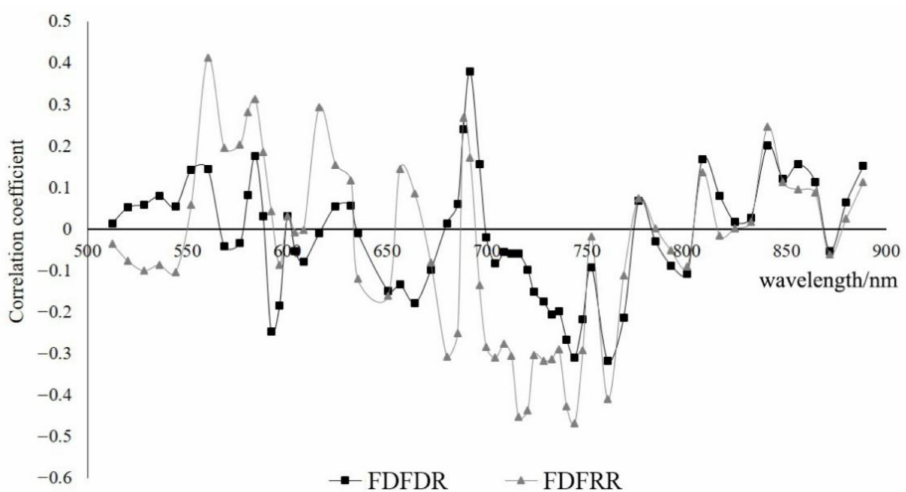
Figure 5. Correlation between rice yield and the first derivative florescence difference reflectance (FDFDR), rice yield and the first derivative florescence ratio reflectance (FDFRR) at the 7th day of